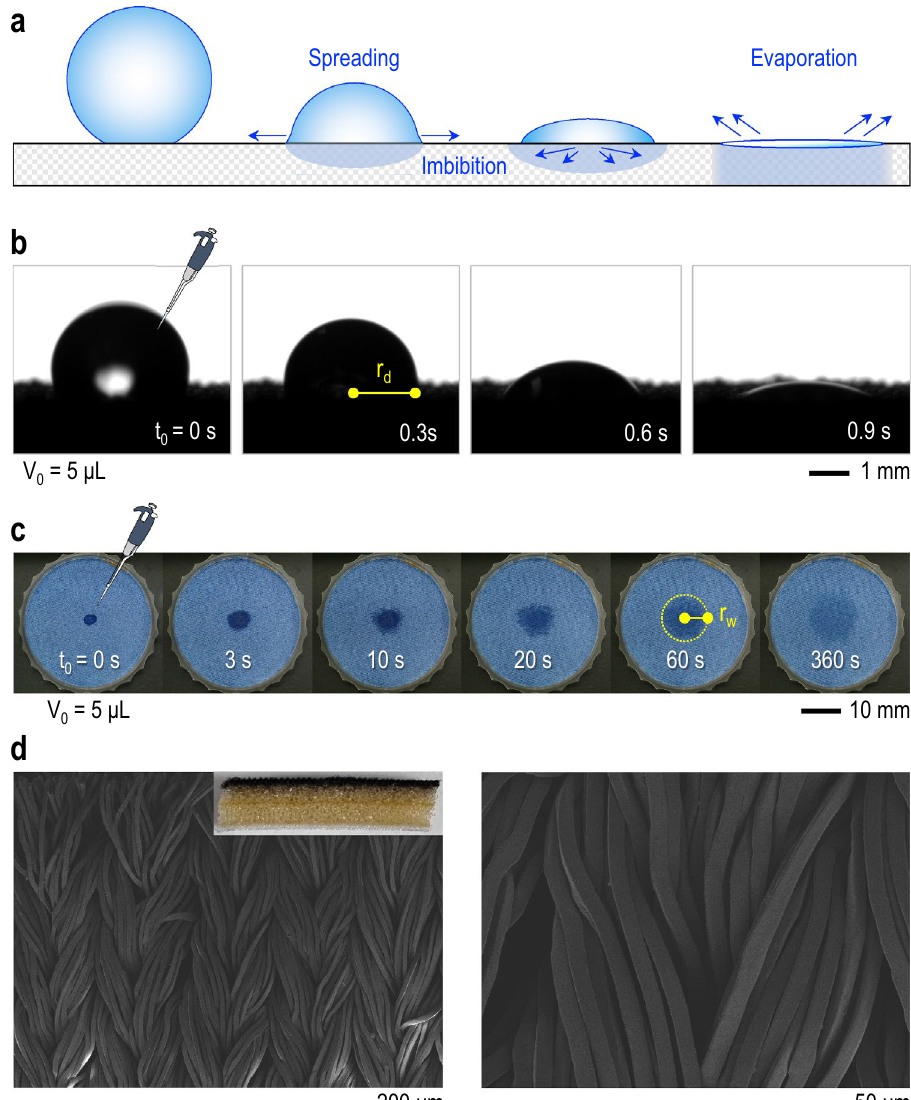
Figure 1. Droplet evaporation on porous media. (a) A combination of spreading, imbibition, and evaporation dynamics for a droplet on a porous substrate. (b) Side-view observation of a water droplet contact radius ( r d ) and surface area variation on a porous substrate (Acquired with Advance Software, Krüss Science). (c) Top-view observation of a radius ( r w ) corresponding to the wetted surface area on a porous substrate. Here, t 0 corresponds to the droplet deposition onto the porous substrate. (d) SEM images of the porous fabric material surface (Acquired with S-3000H, Hitachi). The inset digital-camera image shows the complete fabric